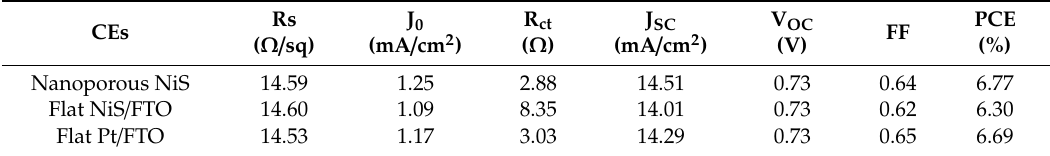
Table 1. Photovoltaic parameters of the counter electrodes (CEs) a .